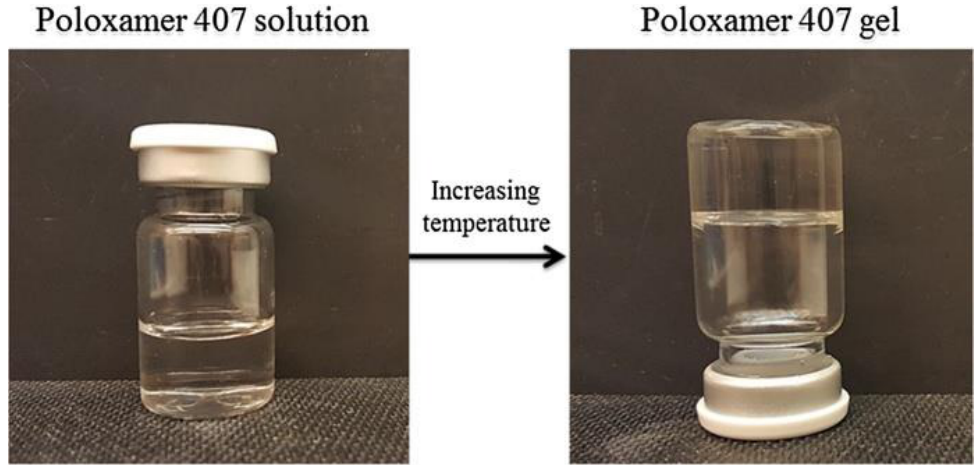
Figure 3. Sol-to-gel transition of poloxamer 407. T sol – gel in thermo-sensitive gels is dependent on the polymer concentration. The image has been taken from the publication by Fakhari et al. [38] with permission.